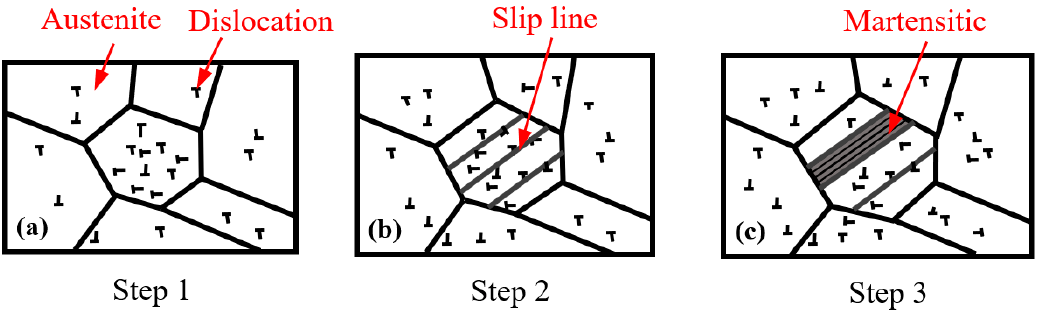
Figure 12. Process diagram of martensite transformation. ( a ) Original state, ( b ) slip plane formation, ( c ) martensite formation.